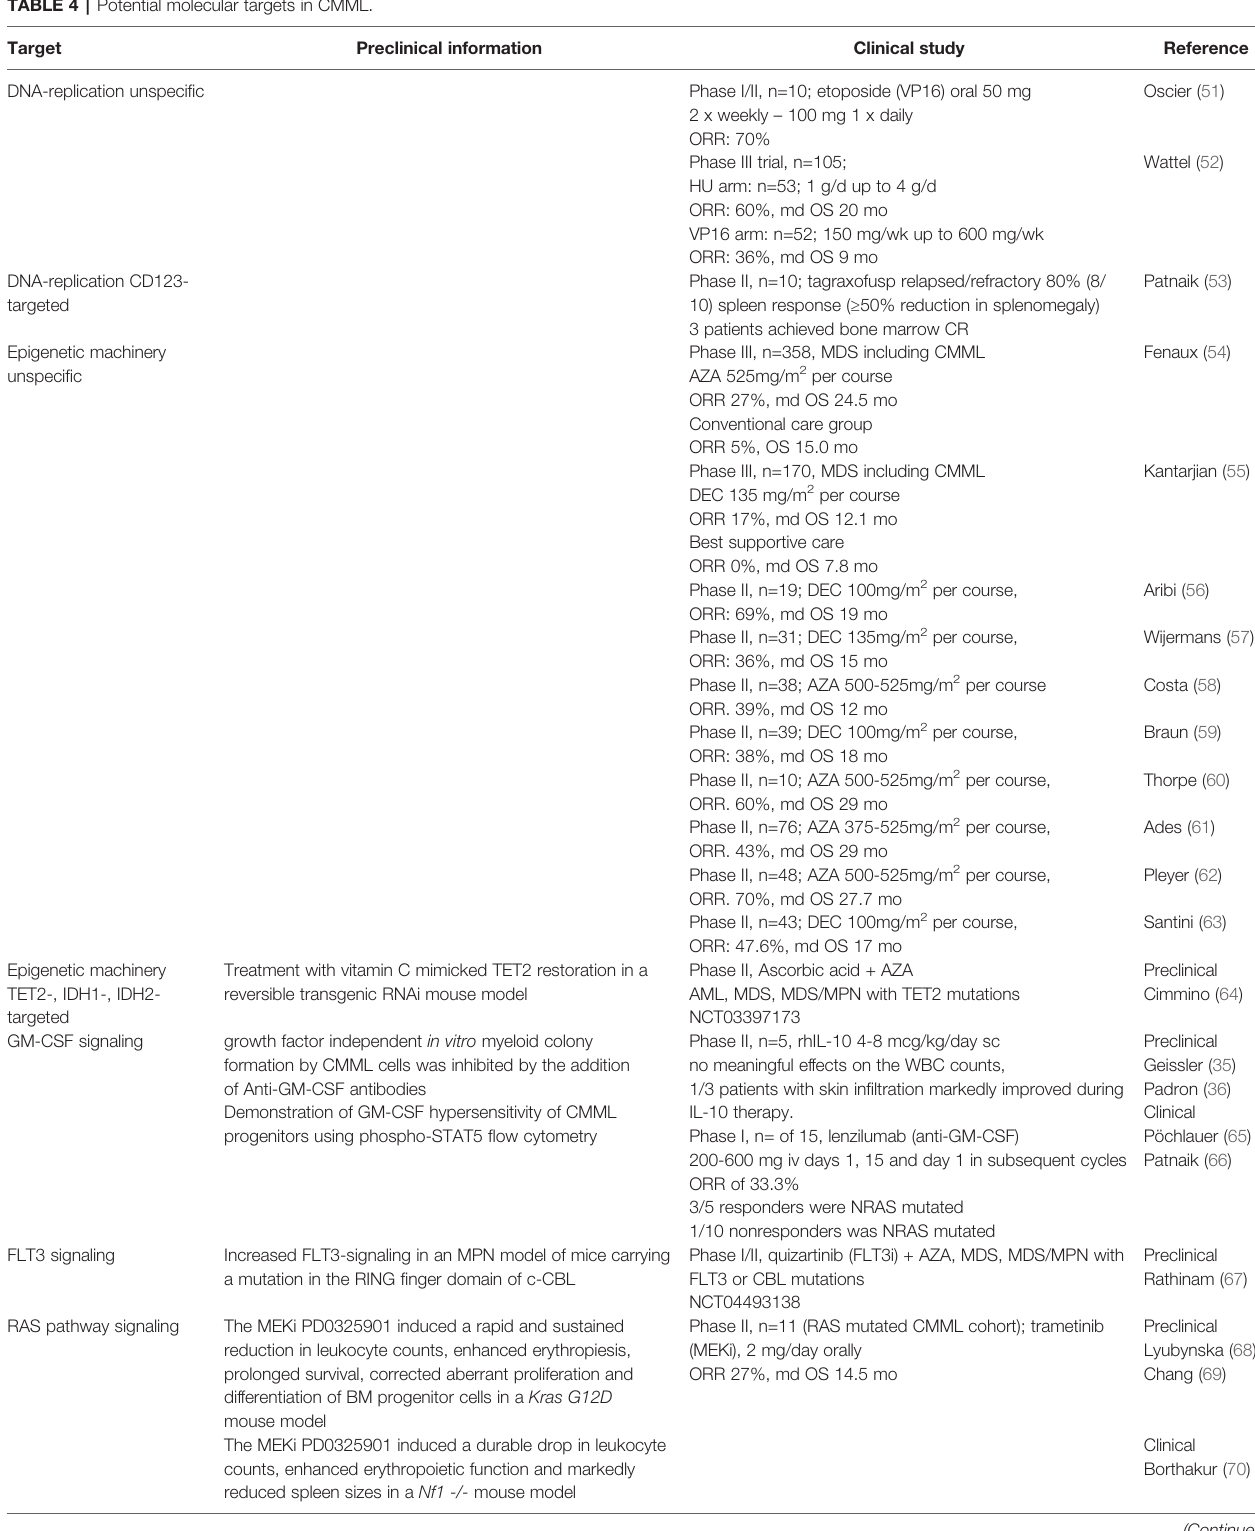
TABLE 4 | Potential molecular targets in